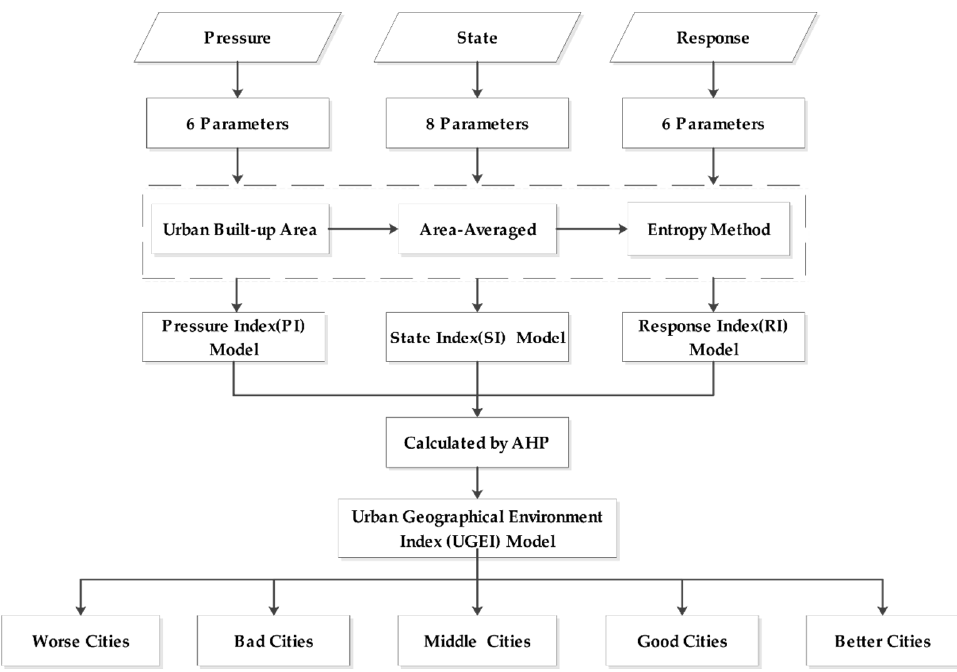
Figure 2. The proposed UGEI Framework. Environmental pressures are mainly analyzed from the aspects of population, indus- trial structure, and pollutant emissions. P1 reflects the population pressure, P2 represents the industrial pressure, and P3–P6 reflects typical pollutants and waste disposal. The state of the environment depends on the abundance of organisms, land cover [34], and water and air quality. S1 is a biological abundance index that is widely used to reflect biological abundance, S2 reflects the building area in land cover, S3–S6 reflect the distribution of cultivated land, forest land, grassland, and other vegetation coverage lands [35,36], S7 reflects the water resource status, and S8 shows the overall situation of air quality. Human responses are key factors that mainly include prevention, protection, afforestation, and investment. R1 reflects the afforestation situation, R2 and R3 reflect the environmental pro- tection investments, and R4–R5 reflect the pollution control. S1–S7 originate from remote sensing monitoring in China’s first national geographic survey, and the others are from the statistical